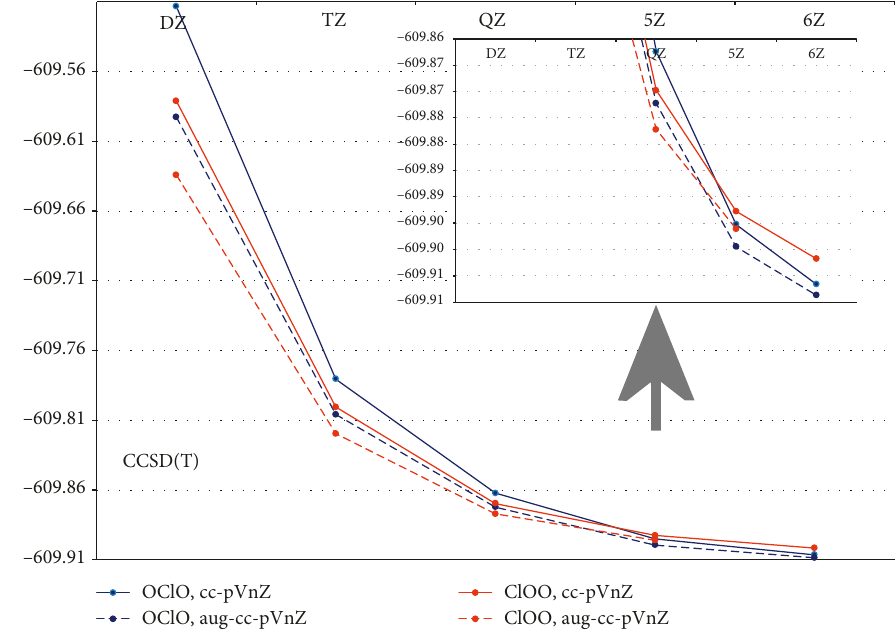
Figure 12: Total energies (in Hartree) for the isomers ClOO and OClO calculated at the CCSD(T) level employing cc and aug-cc basis sets. The inset shows an enlargement of the region of results with the larger basis